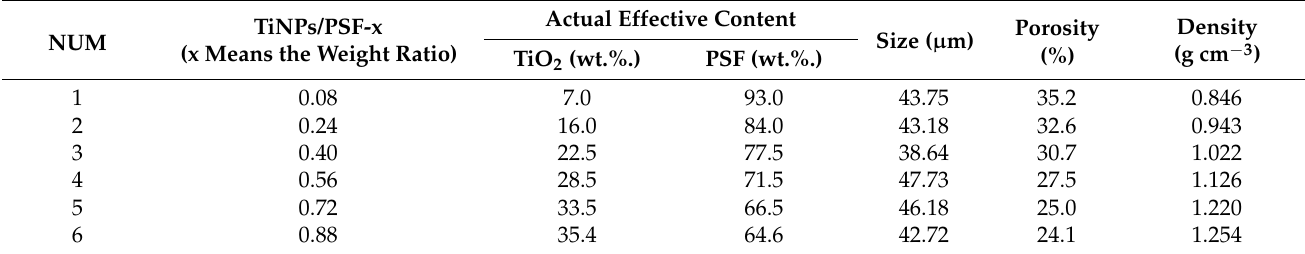
Table 1. The microsphere size, actual effective content, density and porosity parameters of TiNPs/PSF. NUM